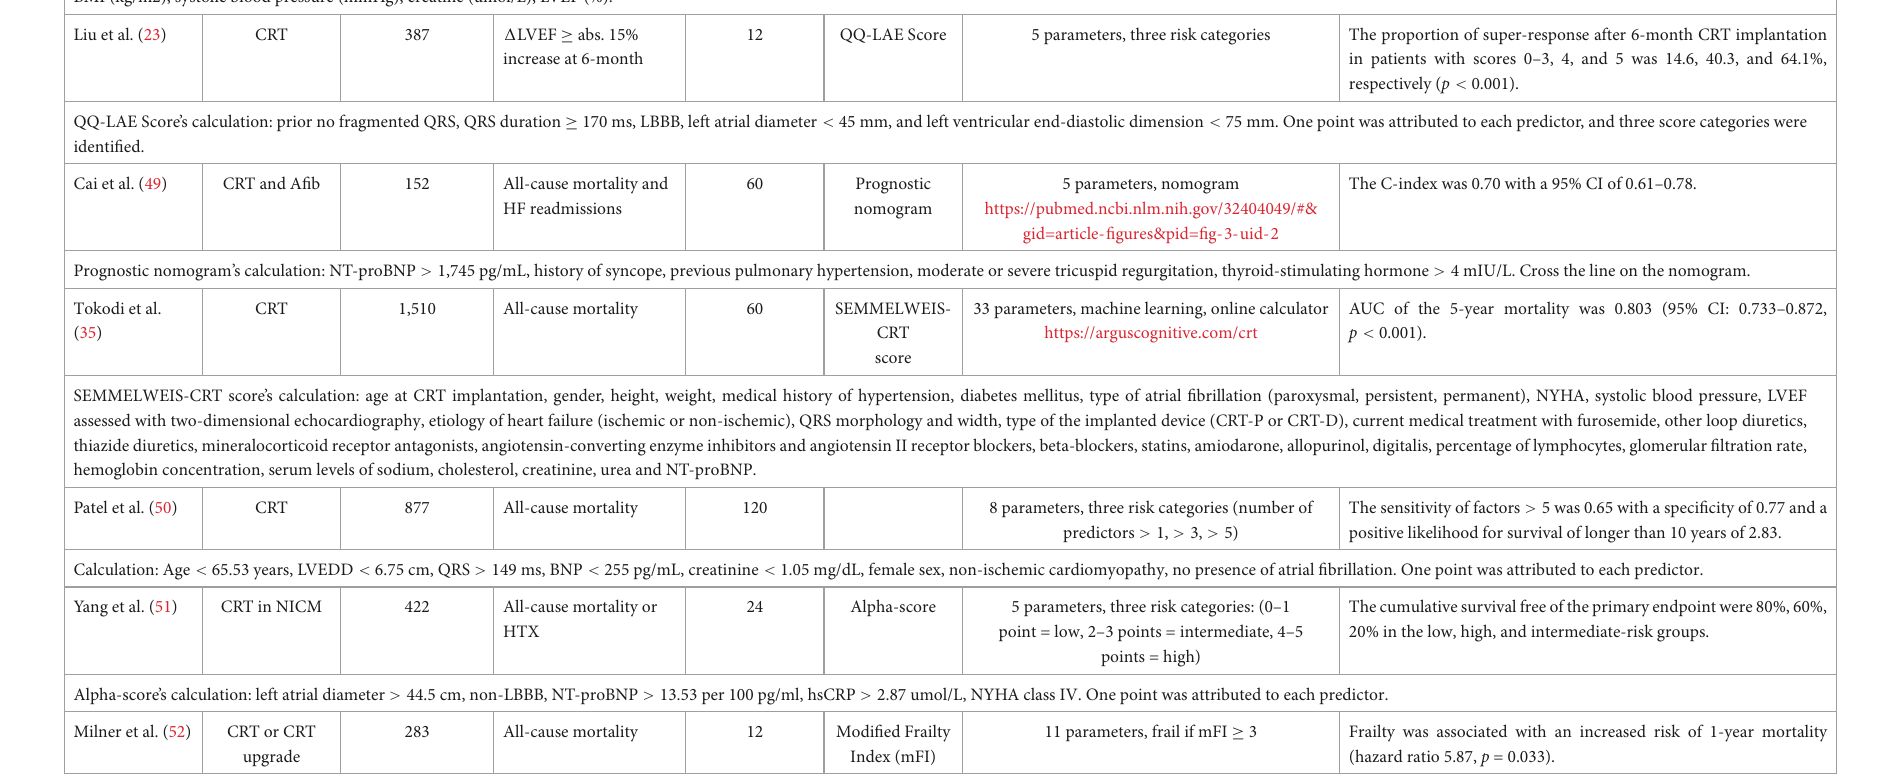
13 parameters, three risk categories: low:0–16 points, intermediate: 17–24 points, high: > 24 points.